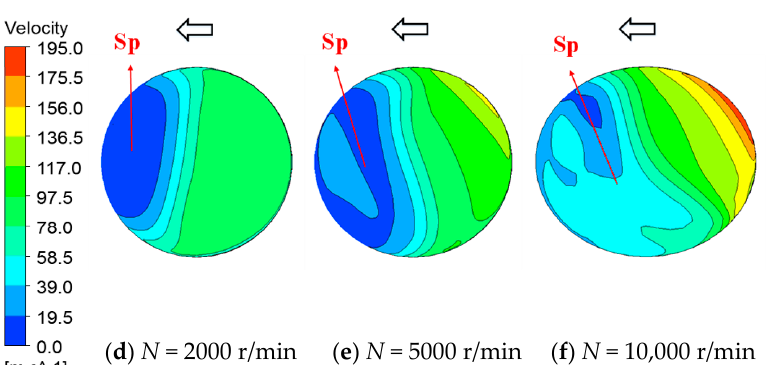
Figure 18. Velocity contour diagram of the orifice exit. ( a ) β 0 = 0 ◦ , i = − 35.7 ◦ , C d = 0.378, ( b ) β 0 = 15 ◦ , i = − 35.3 ◦ , C d = 0.510, ( c ) β 0 = 30 ◦ , i = − 37.1 ◦ , C d = 0.639, ( d ) β 0 = 0 ◦ , i = 14 ◦ , C d =0.632, ( e ) β 0 = 15 ◦ , i = 16.4 ◦ , C d = 0.502, ( f ) β 0 = 30 ◦ , i = 18.4 ◦ , C d =